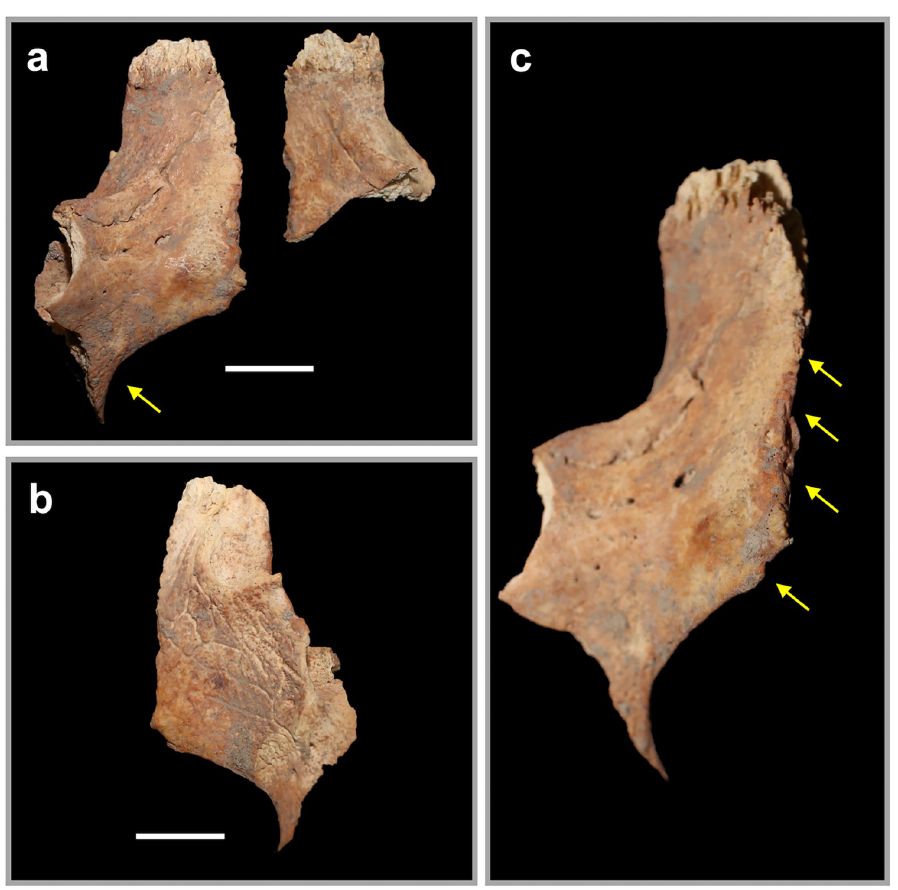
Fig 10. The eroded maxillae of Individual 2. a: Right and left maxillae in anterior view with arrow pointing to widened nasal aperture. b: Right maxilla in medial view. c: Right maxilla in anterior view with arrow pointing towards eroded nasomaxillary border. Scale bars are